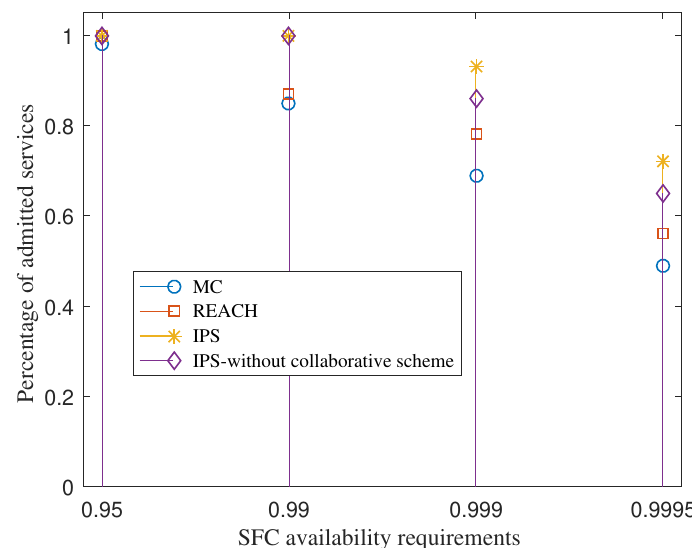
Figure 5. The percentage of admitted services under various service reliability